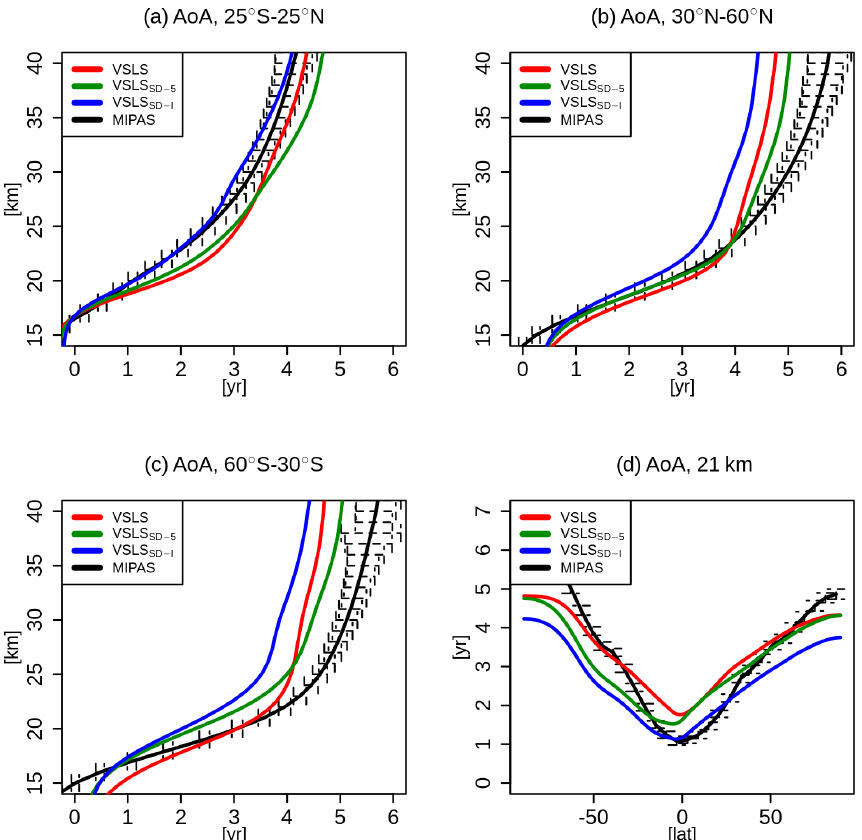
Figure 7. Normalised age-of-air [year] for (a) 25 ◦ S–25 ◦ N, (b) 30 ◦ S–60 ◦ N, (c) 30 ◦ N–60 ◦ S and (d) at 21km, diagnosed from the free- running VSLS (red) and the nudged VSLS SD-5 (green) and VSLS SD-I (blue) simulations. Black shows the corresponding AoA derived from the MIPAS SF6 satellite observations (black; Stiller et al., 2020). Both model and observed AoA were averaged over the seven-year period from May 2005 to April 2012 inclusive. Both model and observed AoA were normalised to be zero at the tropical tropopause by subtracting the values calculated in each case for the tropical tropopause layer (here approximated as mean over 25 ◦ S–25 ◦ N,